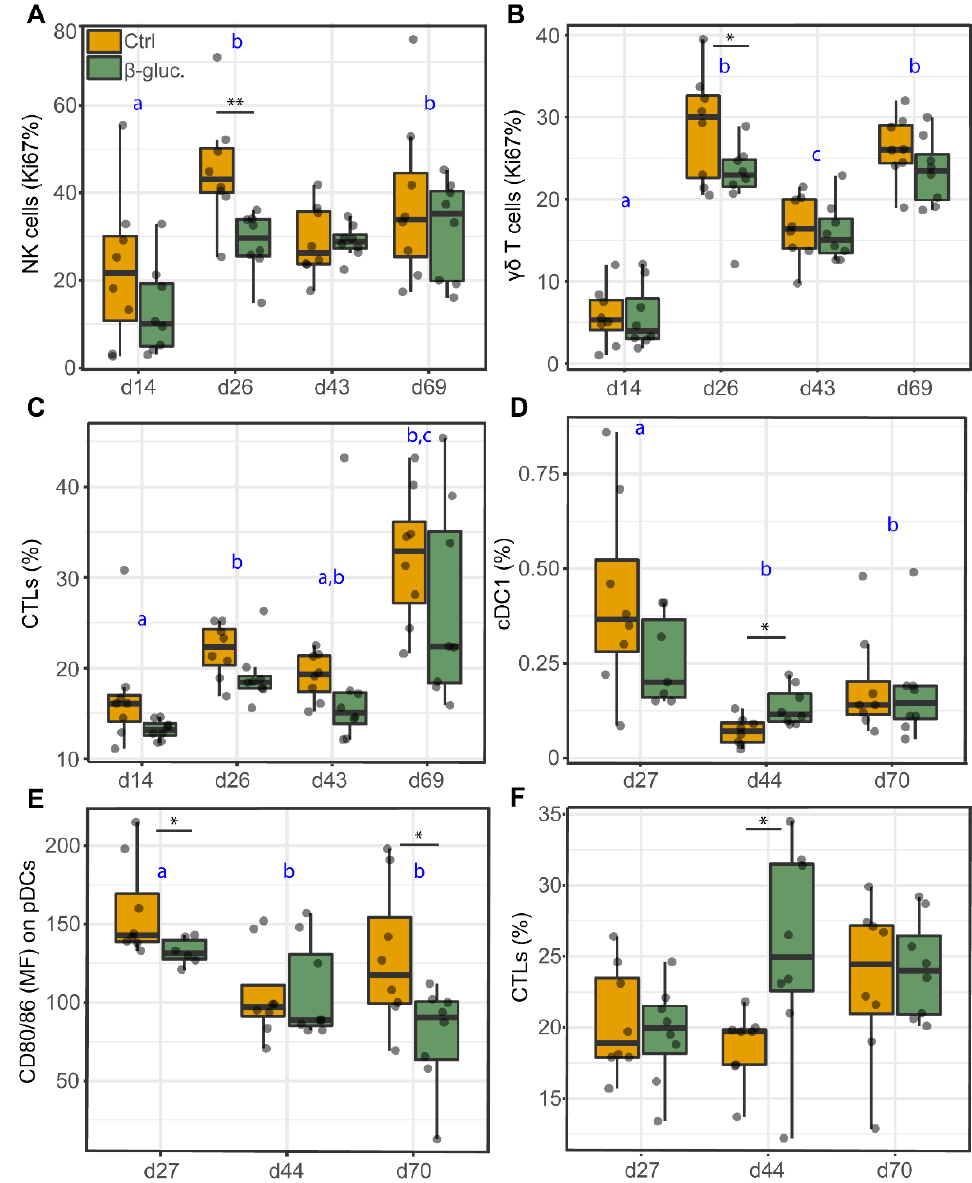
Figure 8. Cell analysis of different immune cell populations from PBMCs ( A – C ) and MLN cells ( D – F ). Significant differences between treatments are indicated by asterisks (**; p < 0.01 and *; p < 0.05). Letters (a, b, c) represent significant differences ( p < 0.05) between time points. Data were presented as the percentage of proliferating cells (Ki67%; A , B ), percentage of cells (%; C , D , F ), or mean fluorescent intensity (MFI; E ). Every dot represents a single animal from a different pen ( n = 7 or 8 per treatment group) and error bars represent standard deviations. Statistical analysis was performed for every time point (T-test) and over time (Two-way ANOVA). All data were checked for normal distribution and equal variances and log-transformed when required.